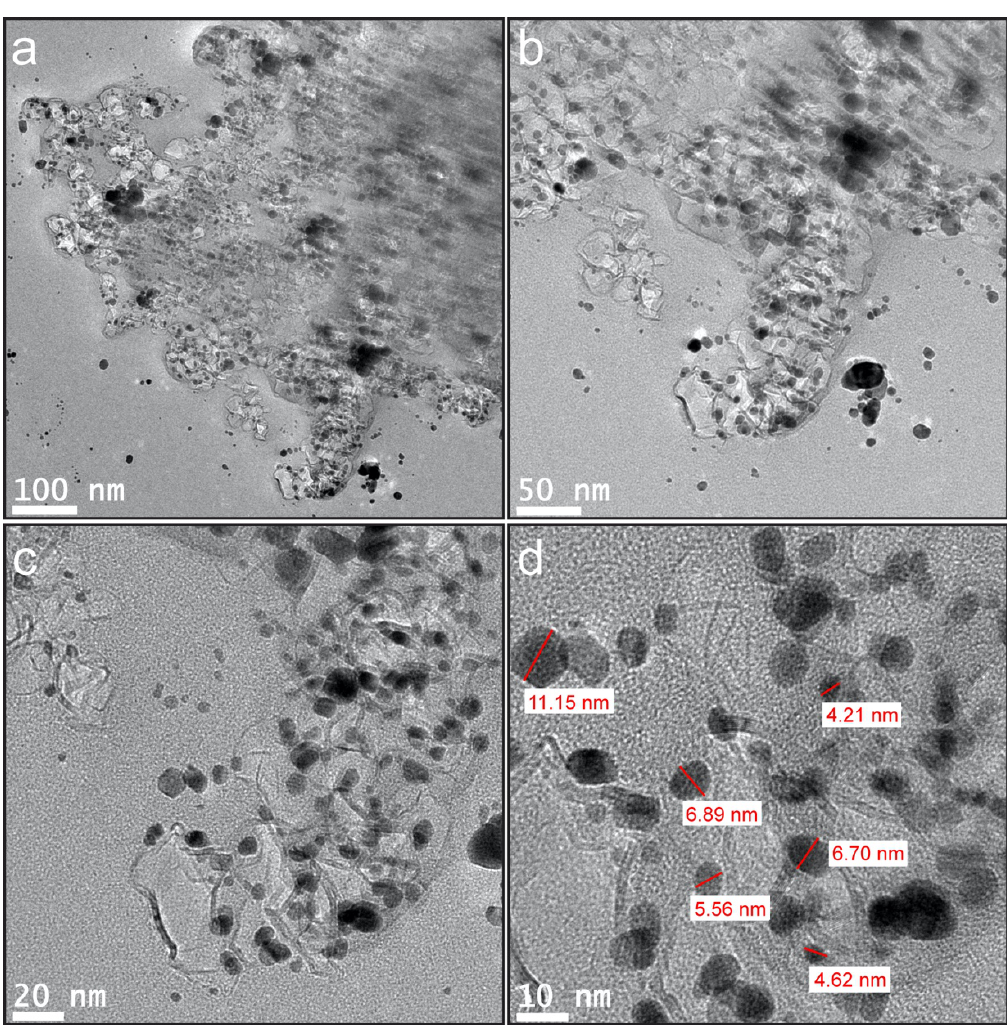
Figure 2. ( a )–( c ) HR-TEM micrographs of CuO-SWCNT nanocomposite with successively higher magnification ( d ) Measurement of particle size of CuO nanocrystals.